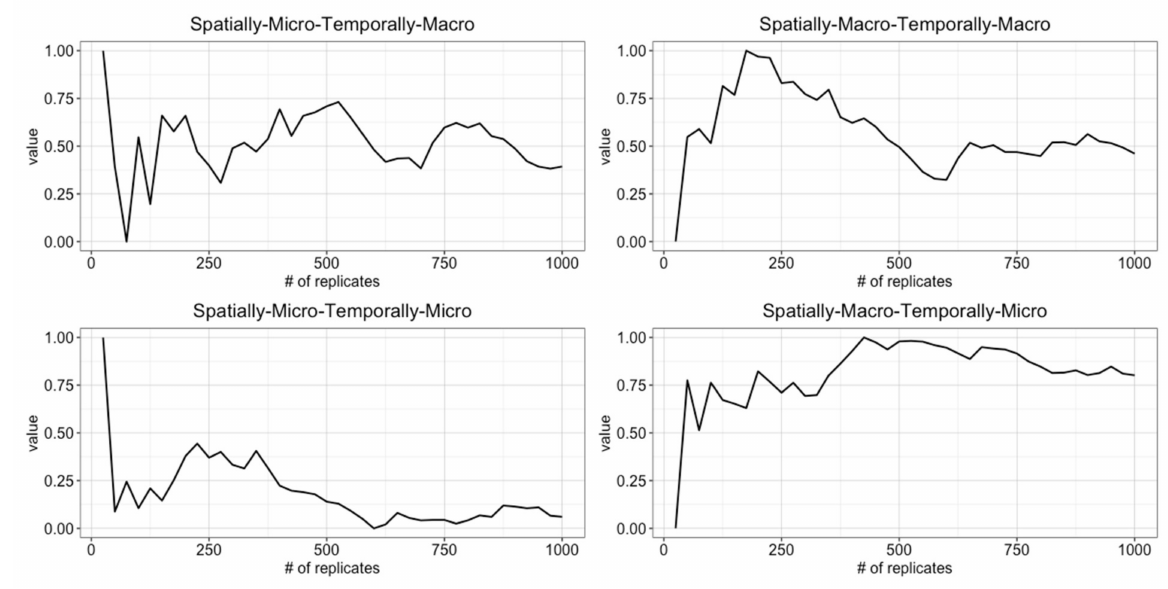
Figure 6. Normalized coefficient of variance of the simulated outputs over the number of